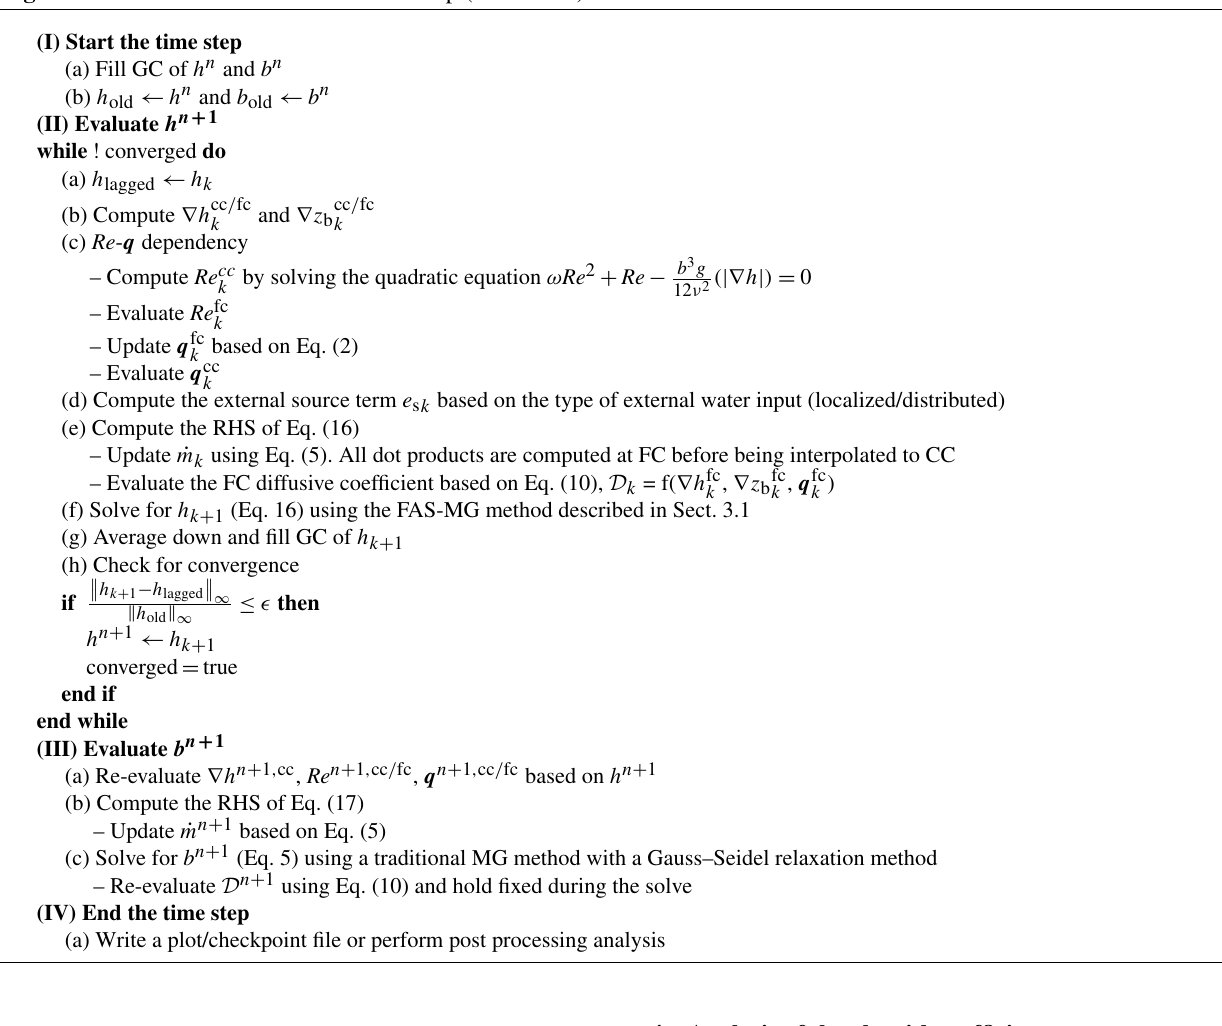
Algorithm 1 Skeleton of a SUHMO time step ( t n → t n + 1 ).